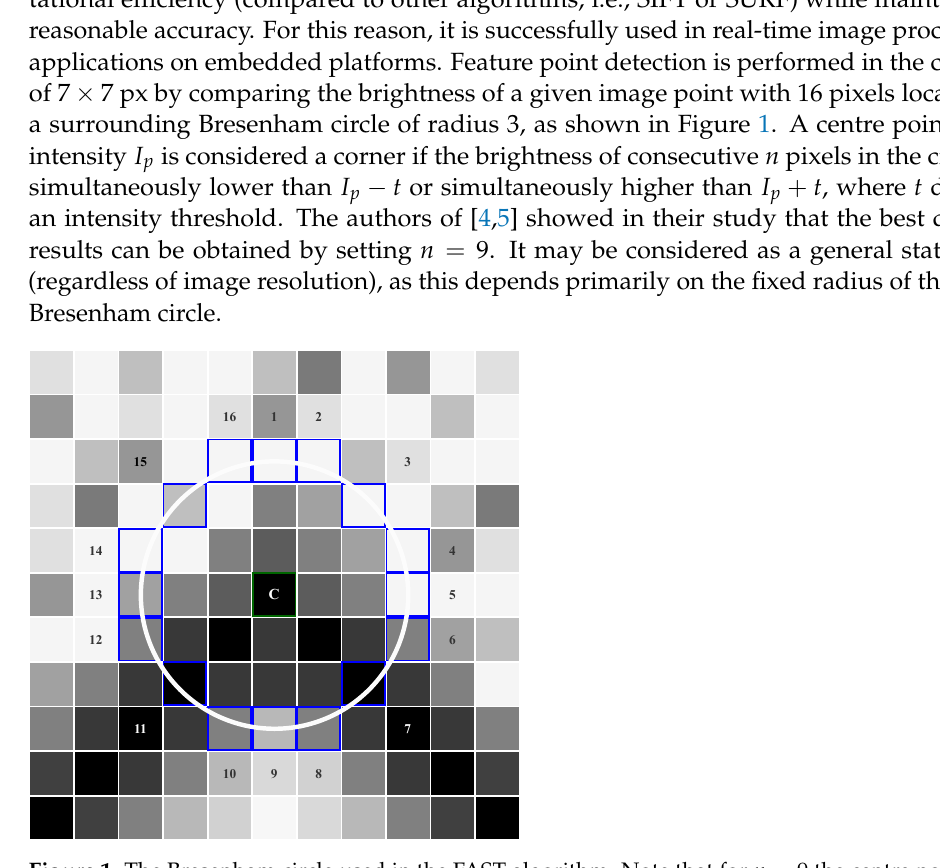
Figure 1. The Bresenham circle used in the FAST algorithm. Note that for n = 9 the centre point will be detected as a corner for a relatively wide range of possible thresholds t